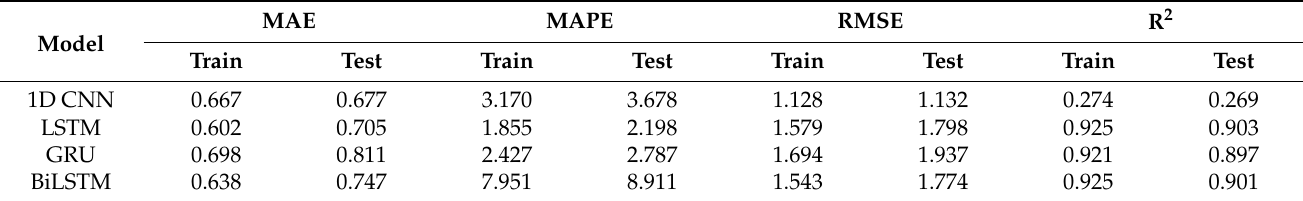
Table 4. Comparison among deep-learning models in terms of different error